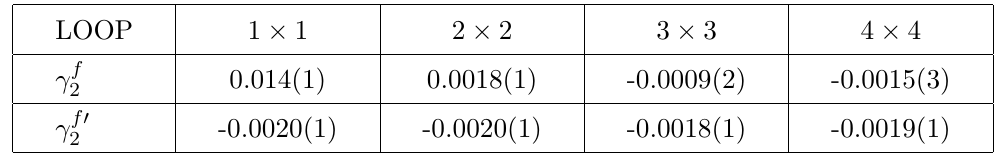
and (cid:13) f 0 entering the large L expansion of the 2 2